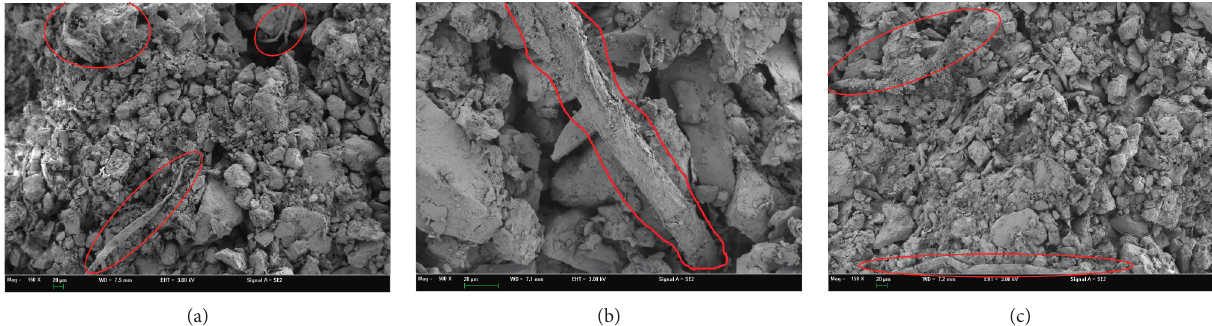
Figure 26: The microstructure of PAM and lignocellulose composite-stabilized soil. (a) 0 cycles. (b) 3 cycles. (c) 10